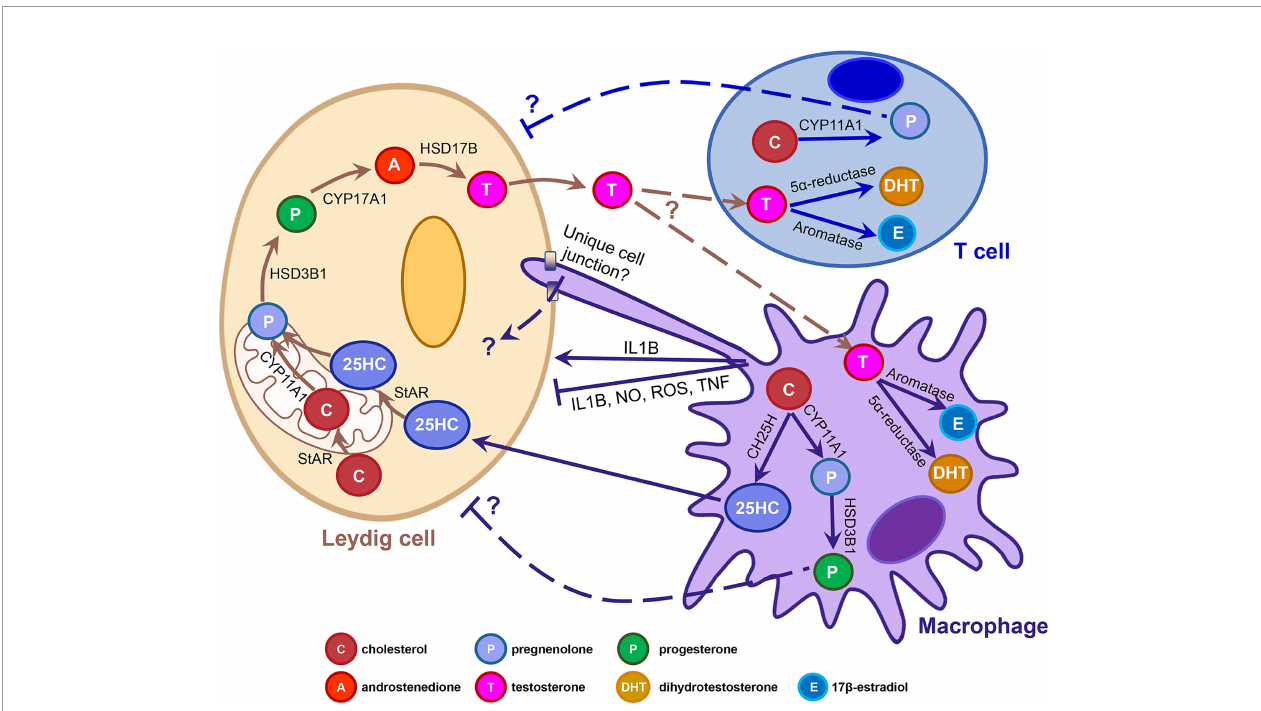
FIGURE 1 | Potential mechanisms underlying macrophage-Leydig cell interactions and immune cell steroidogenesis. Cartoon depicts the adult rodent testicular interstitium, containing a Leydig cell, macrophage, and T cell. Arrows denote the different molecular and cellular pathways that have been implicated in macrophage- Leydig interactions and de novo steroidogenesis by immune cells. T-shaped lines indicate an inhibitory interaction. Dashed arrows and lines fl anked by question marks indicate that interactions have been proposed but have not been demonstrated experimentally, nor have mechanisms or factors involved been identi fi ed de fi nitively. 25HC, 25-hydroxycholesterol; CH25H, cholesterol 25-hydroxylase; IL1B, interleukin 1 beta; NO, nitric oxide; ROS, reactive oxygen species; StAR, steroidogenic acute regulatory protein; TNF, tumor necrosis